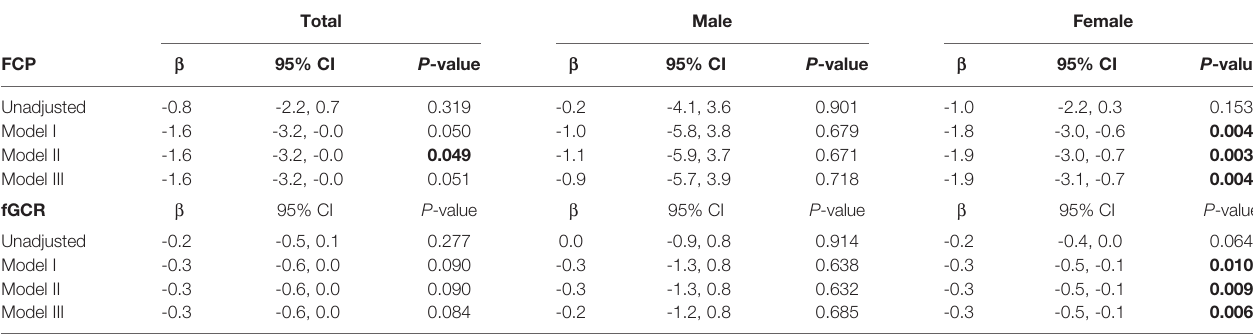
TABLE 3 | Logistic regression used to analyze the association between 1-mg DST inhibition rate and glucose metabolism in men and women. Total Male Female FCP b 95% CI Unadjusted